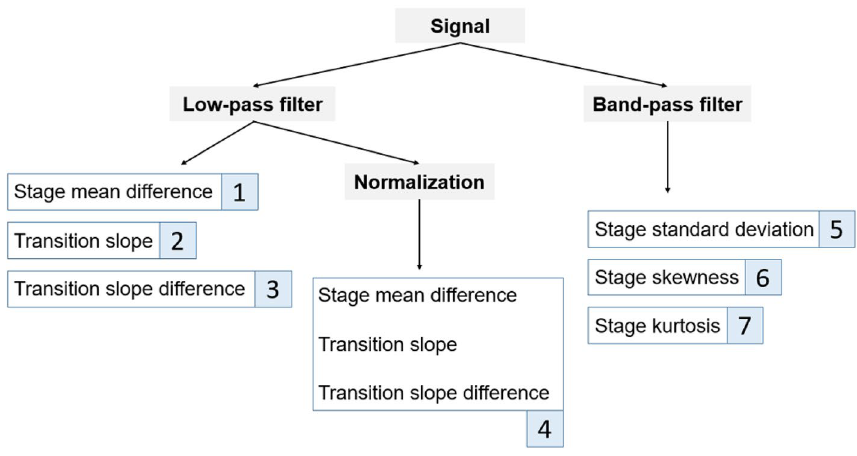
Figure 10. Diagram of